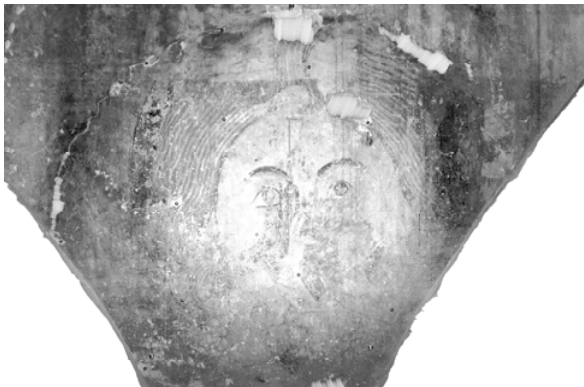
Picture 5. Christopher depiction - Orthoimage from